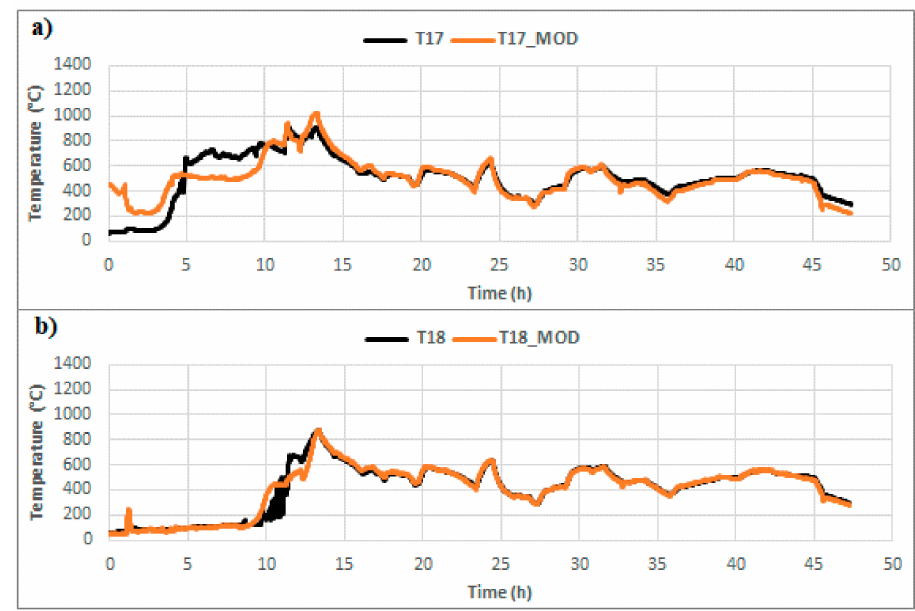
Figure 18. The measured (T) and modeled (T_MOD) temperature behavior by using modified regression models, ( a ) temperature T 17 , ( b ) temperature T 18 (Source: own